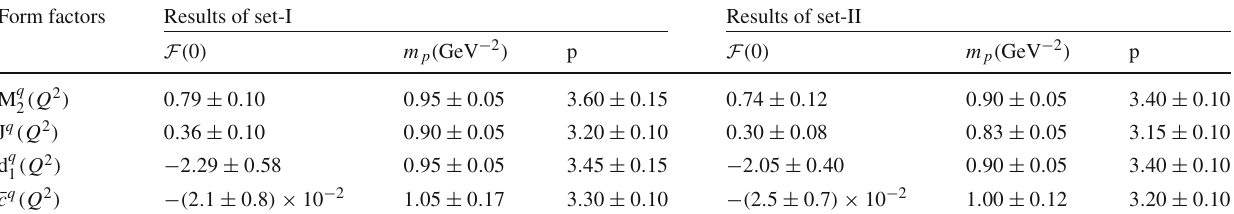
Table 2 The numerical values of multipole fit parameters F ( 0 ) , m p and p for different EMTFFs obtained using the set-I and set-II distribution amplitudes Form factors